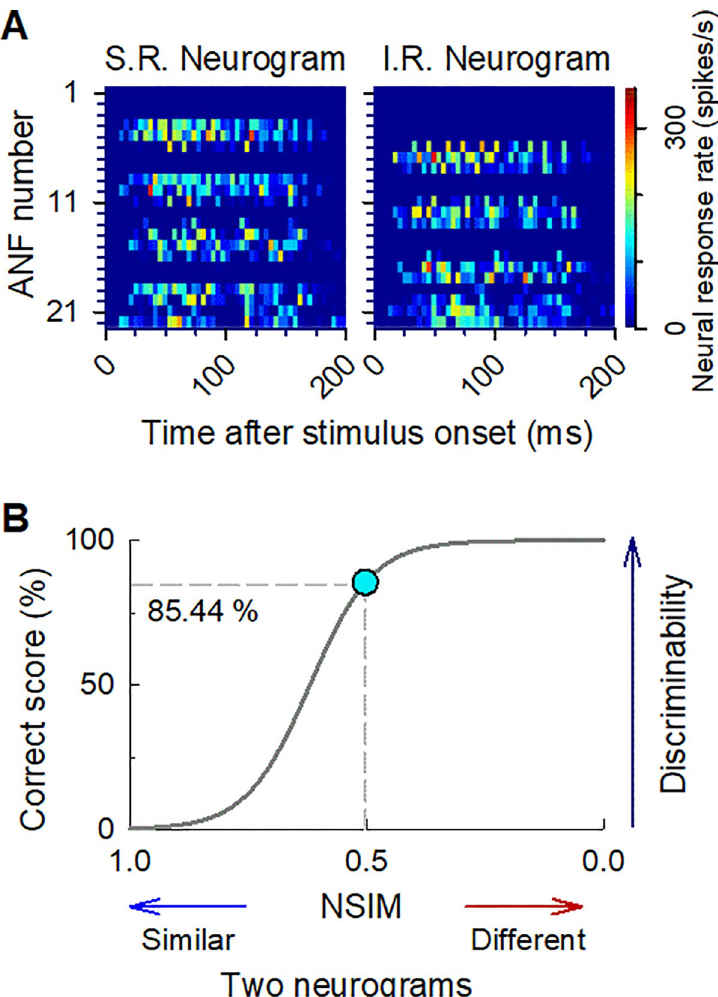
Fig 3. Procedure for calculating the correct score for spectral ripple discrimination. (A) Example neurograms for standard (left) and inverted (right) ripple noises with 1 r/o. In the neurograms, the differing extents of neural activity are depicted by a color scale, from 0 (blue) to 360 (red) spikes/s over time, which is represented by the horizontal axis. (B) Correct score function for converting the NSIM into the correct score. An NSIM of 0.5, which is comparable to that between the neurograms in (B), converts into a correct score of